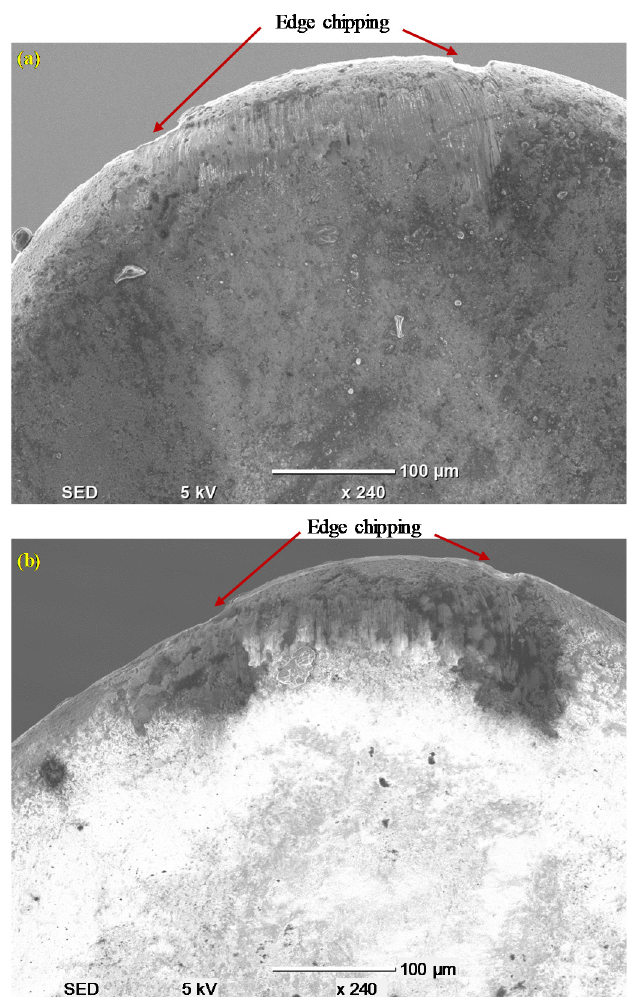
Figure 6. Wear on the rake face of the inserts after L = 400 mm: ( a ) conventional insert and ( b ) wiper insert.